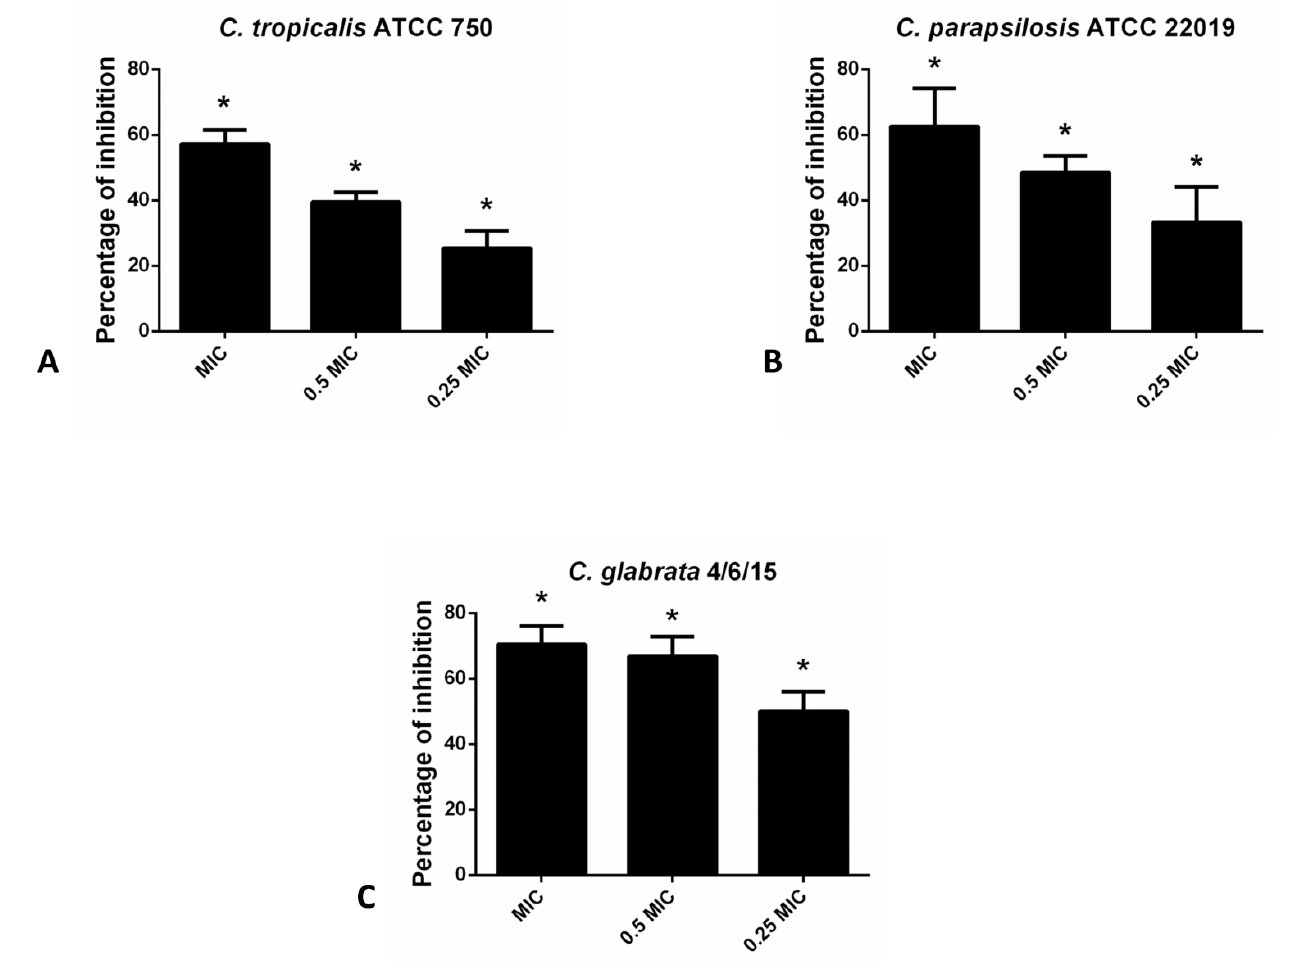
Figure 2. Inhibition of biofilm formation in different non- albicans Candida strains: ( A )- C. tropicalis ATCC 750; ( B )- C. parapsilosis ATCC 22019; ( C )- C. glabrata 4/6/15 after application of hesperetin in concentrations 0.25 MIC (0.041 mg/mL), 0.5 MIC (0.082 mg/mL) and MIC (0.165 mg/mL). Mean values of triplicate independent experiments ± SD are shown, * p < 0.05 compared to control.